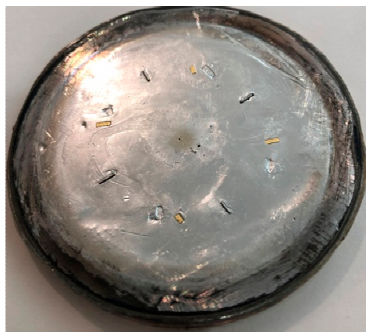
Figure 1. Photo of the tin target with pieces of the metals introducing into the bulk of SnO 2 film. The tin target with the addition of gold and nickel is shown for the best contrast.